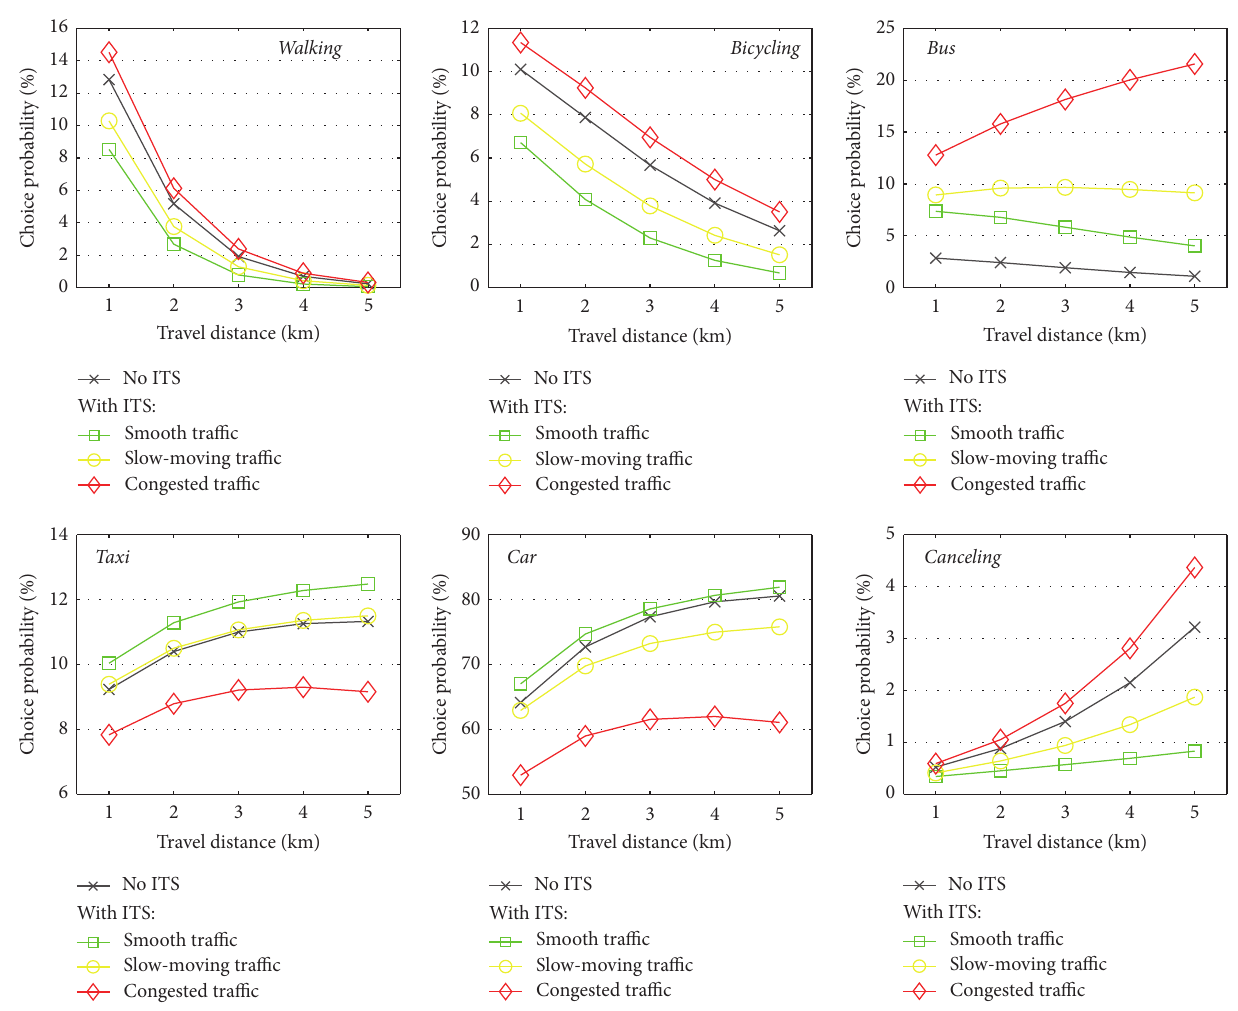
Figure 4: Predicted choice probabilities of FIT by